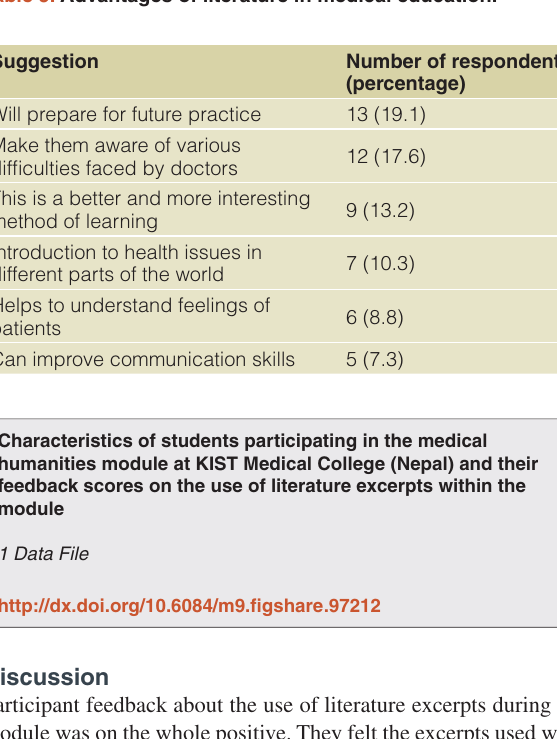
Table 5. Advantages of literature in medical